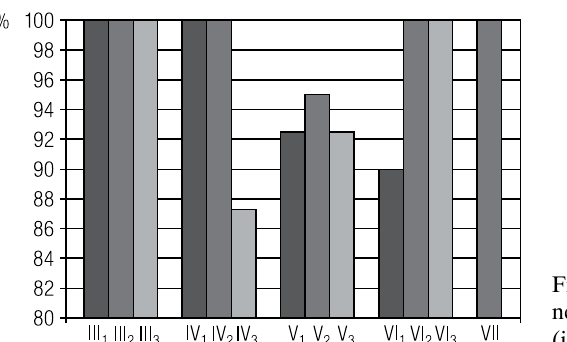
Fig. 2. The colonisation rate of the nest material by cellulolytic fungi (in